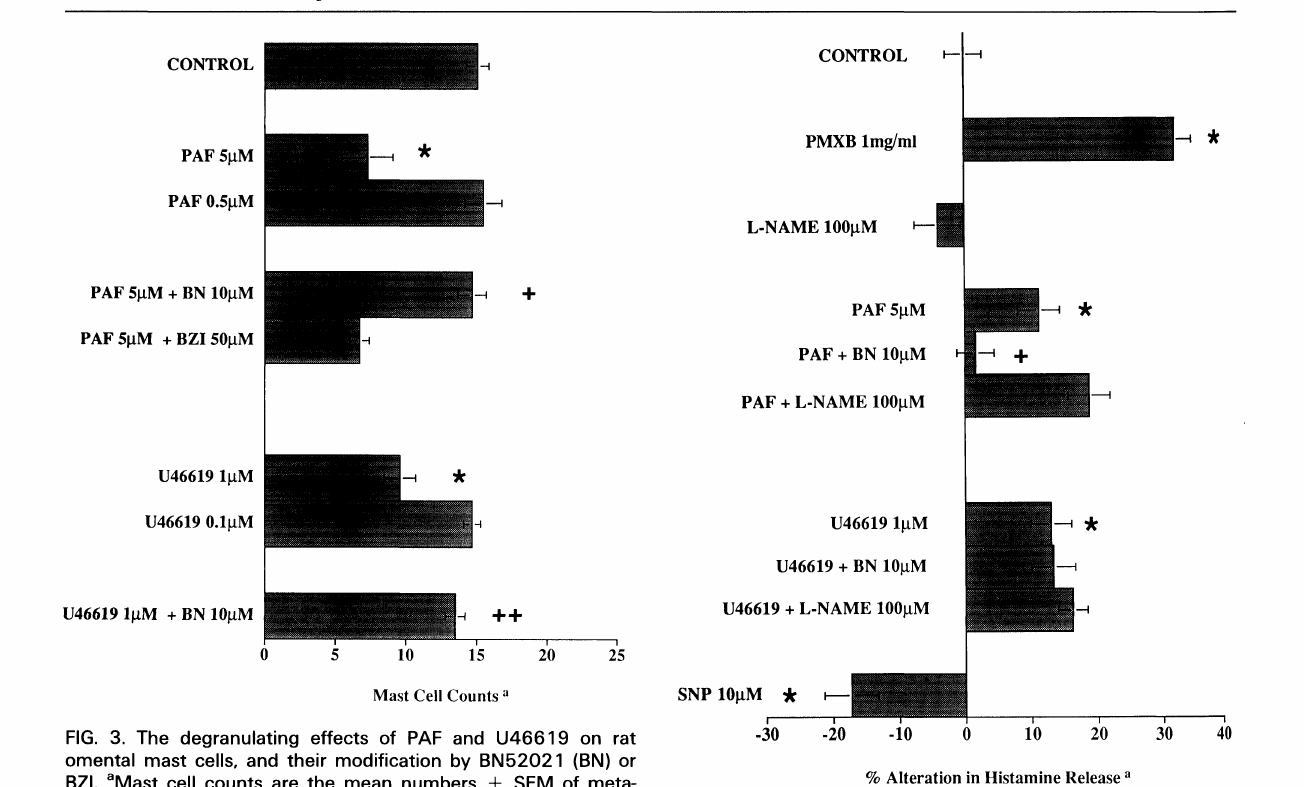
FIG. 3. The degranulating effects of PAF and U46619 on rat omental mast cells, and their modification by BN52021 (BN) or BZI. aMast cell counts are the mean numbers chromatically stained mast cells per omental milky spot. *lower than control value (p < 0.05, Bonferroni’s test); +higher than the value for PAF 5 IM (p < 0.05, Bonferroni’s test); ++higher than the value for U46619 IM (p < 0.05, Bonferroni’s test).